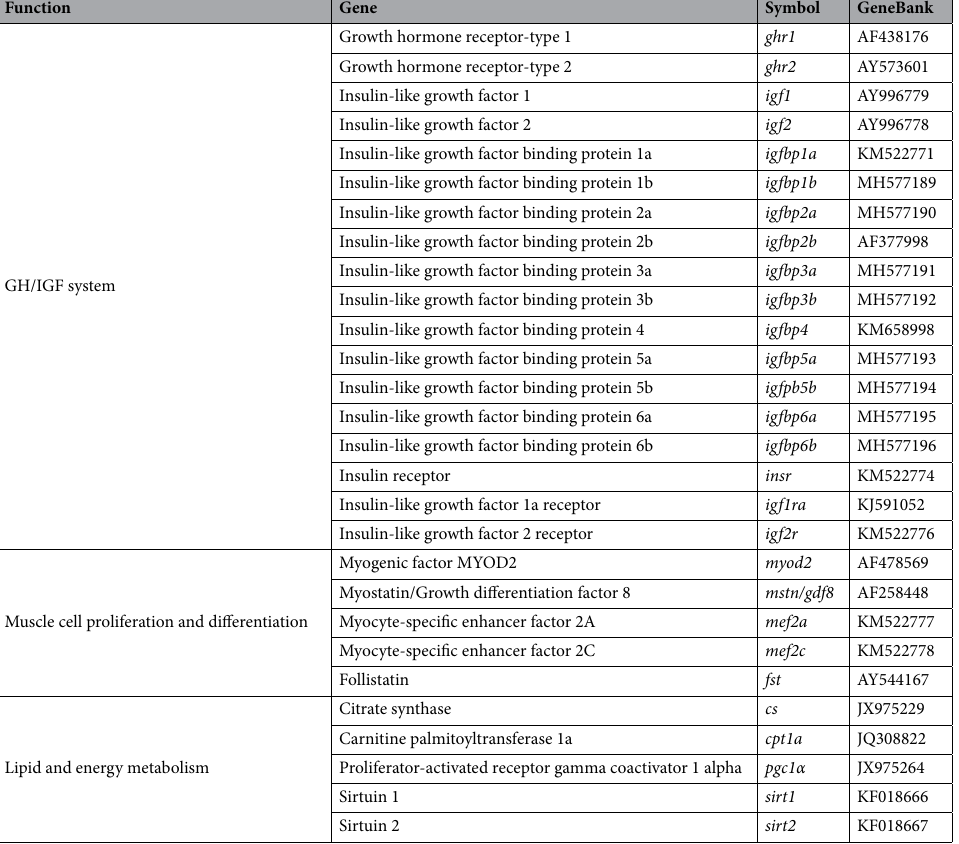
Table 1. PCR-array layout for gene expression